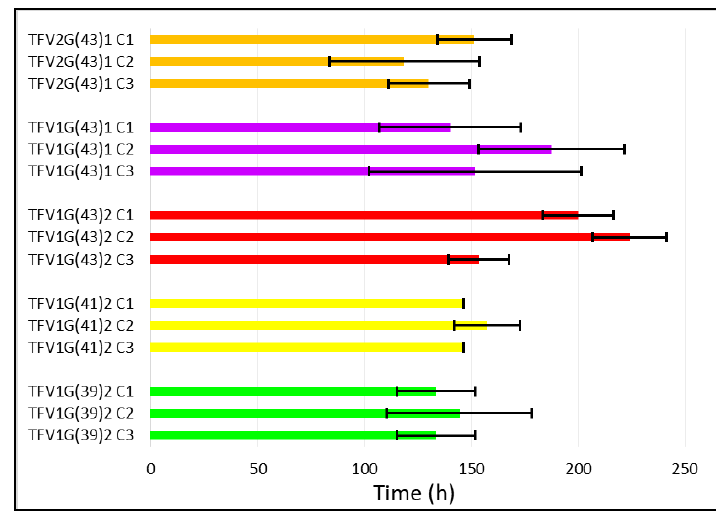
Figure 11. Mucoadhesion residence time in the simulated vaginal fluid in the batches.